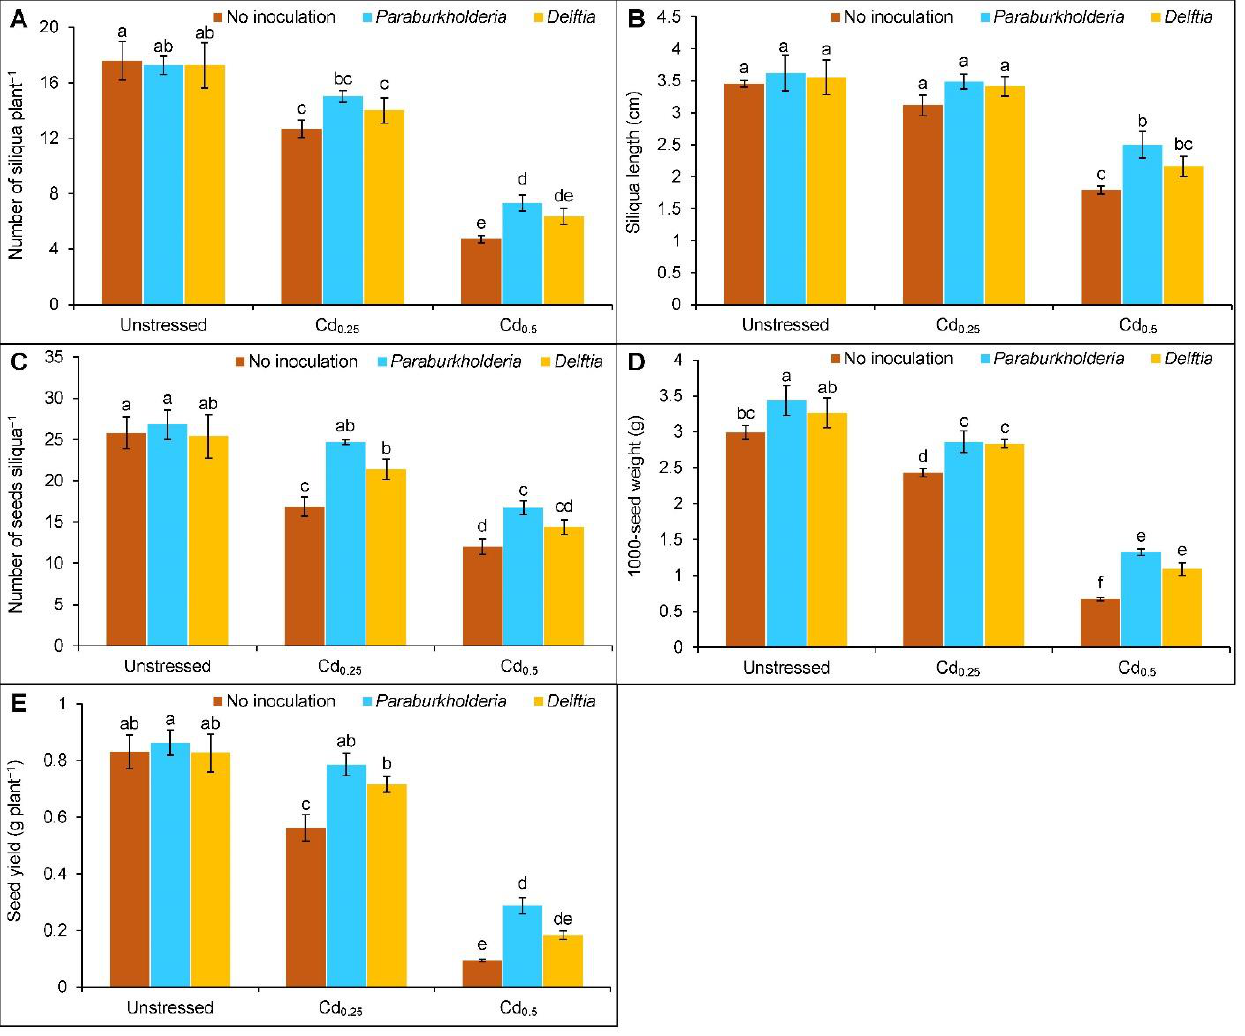
Figure 7. Effect of Paraburkholderia fungorum and Delftia sp. on the ( A ) number of siliqua plant −1 , ( B ) siliqua length, ( C ) number of seeds siliqua −1 , ( D ) 1000-seed weight, and ( E ) seed yield plant −1 of rapeseed under different levels of CdCl 2 . Here, Cd 0.25 and Cd 0.5 indicated 0.25 and 0.5 mM CdCl 2 , respectively. Different letters on the bars indicate statistical significance at 5% levels of probability following Tukey’s HSD test and the mean (±SD) values obtained from three replications.